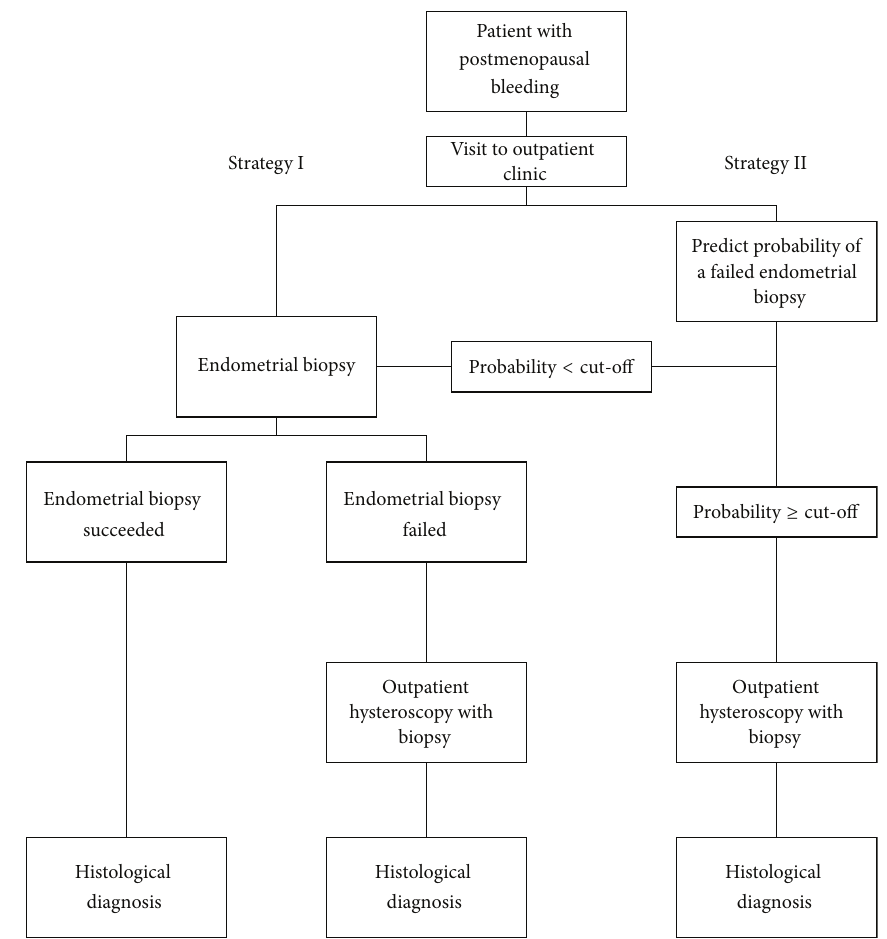
Figure 1: Flowchart representing the two diagnostic